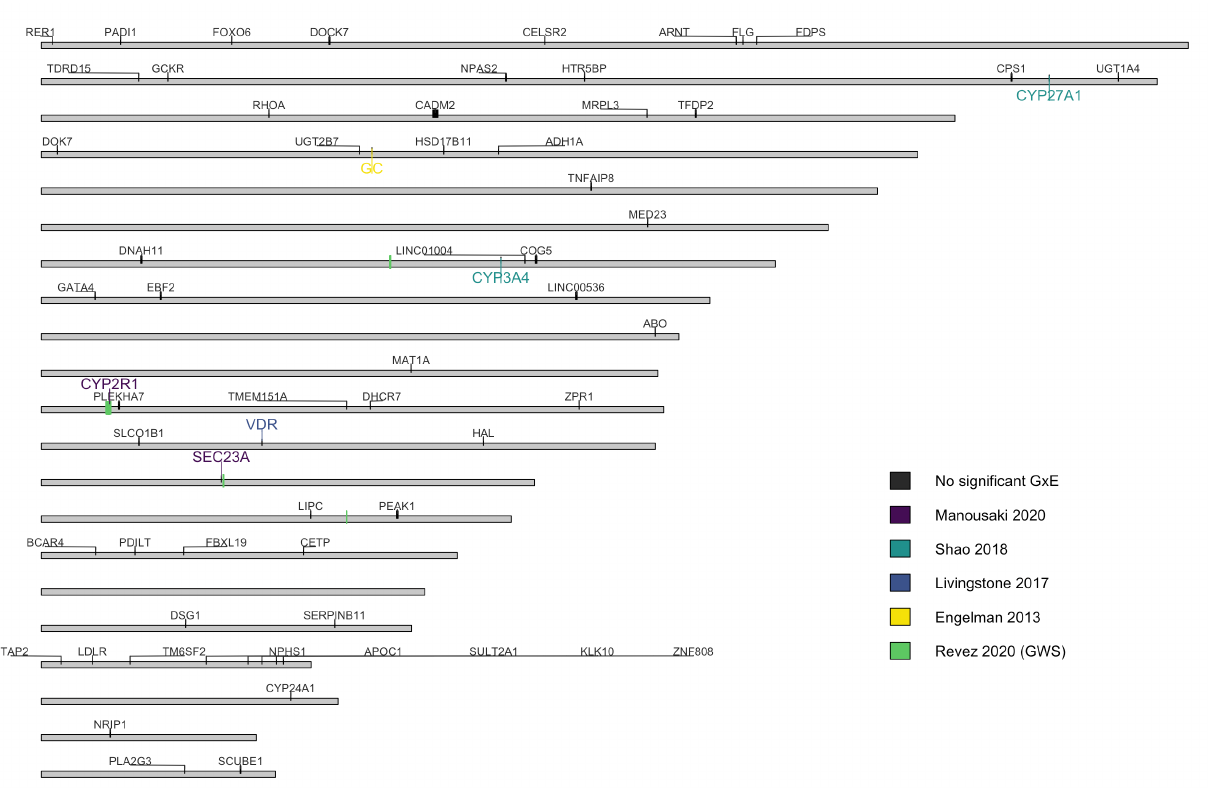
Figure 4. Chromosomal map showing the genes assessed for gene-environment interactions from the studies included in this review [12,27,28,30]. While most of the studies used SNPs, only the genes that those SNPs fall within are shown, for easier visualisation. Revez et al. [16] identified over 1000 SNPs with significant GWS GxE, they are shown as regions on the chromosomes. Hatchell et al. [33] Legend: genes in colour were found to have significant GxE interactions, genes in grey were analysed but not found to have significant interactions in the included studies. Note: chromosomes 13, X, and Y are not shown as they were not included in any of the